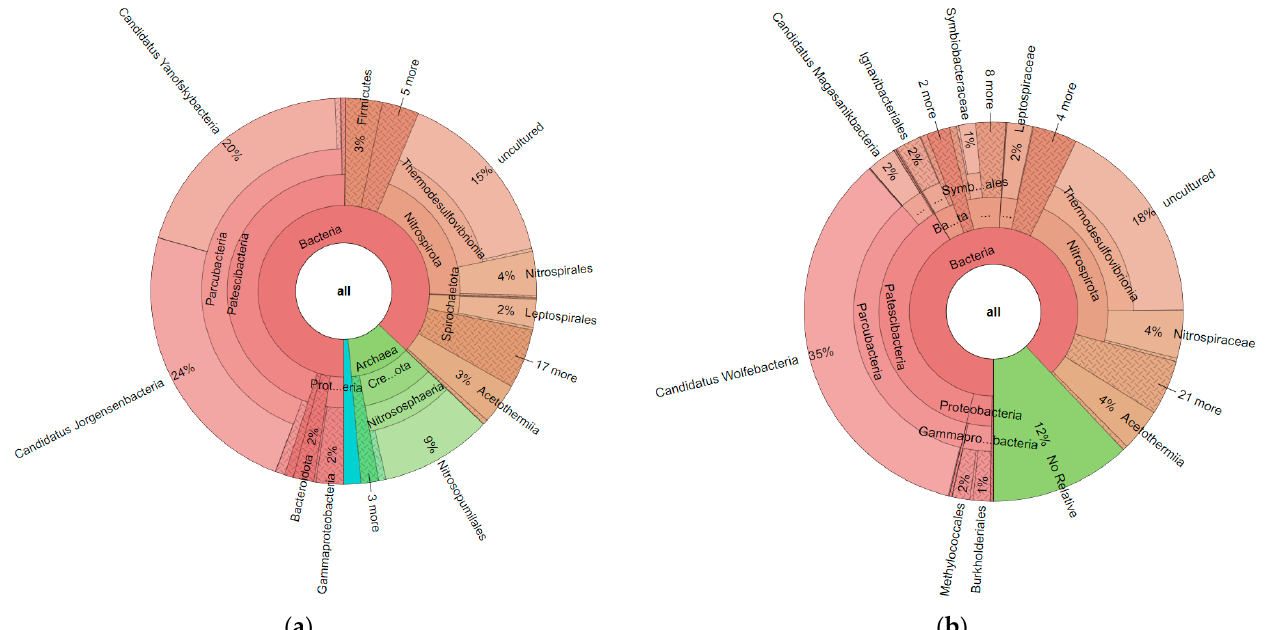
Figure 2. Krona chart results obtained from Yozgat-Bo˘gazlıyan field for c2l100 filter; ( a ): 515F-806R_Reverse; ( b ) 16sV3. Results belong to the pool of triplicate PCR pools of 4 field samples (12 in total).